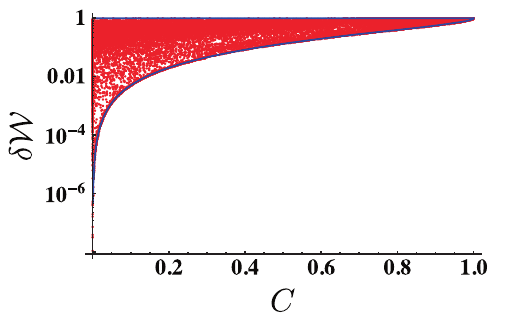
Fig. 3 Distribution of two-qubit states in the daemonic gain-vs.- concurrence plane. We have generated 10 4 general random states of system and ancilla, evaluating the concurrence C and daemonic gain δ W for each of them ( red dots ). The blue curves enclosing the distribution correspond to boundary families discussed in the body of the paper. Notice that states at C ¼ 0 may correspond to arbitrarily large values of the daemonic gain δ lower and upper bounds closes as only pure states achieve maximum discord.